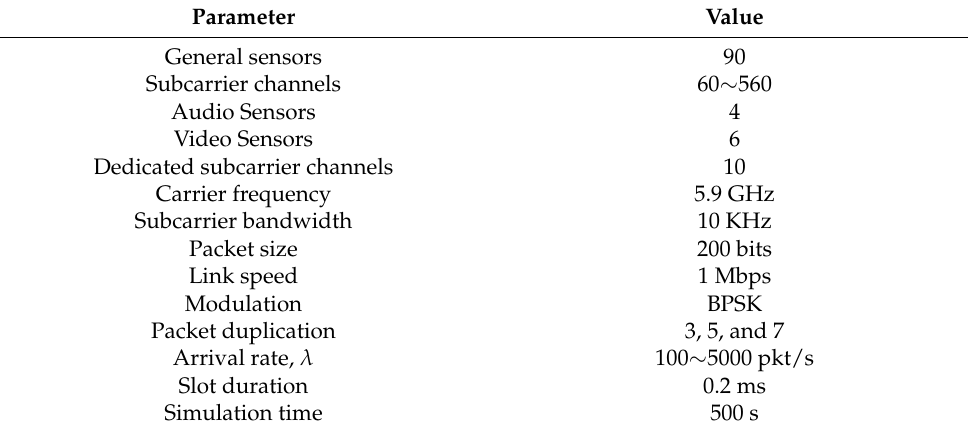
Table 2. Simulation